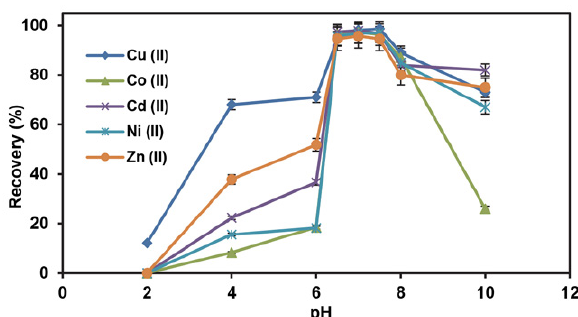
Figure 1. Effect of pH on the recoveries of the analyte ions (sample vol.: 20 mL, eluent vol.: 1 mL, n = 3)